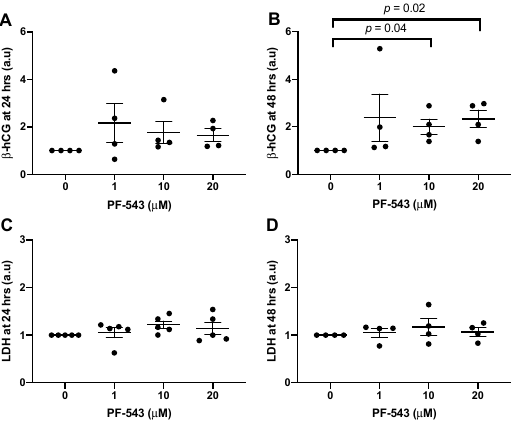
Figure 8. SphK1 inhibition with PF-543 increased β -hCG secretion after 48 h. Explants were pre-cultured for 4 days prior to treatment with a PF-543 dose response (0–20 μ M). Supernatants were centrifuged at 15,000 RPM for 15 min prior to quantification of β -hCG and LDH. ( A ) and ( B ) represent β -hCG released into the supernatant after 24 and 48 h, respectively as measured by ELISA. ( C ) and ( D ) represent LDH released into the supernatant after 24 and 48 h, respectively as measured with a colorimetric assay. Results were normalized against total protein mass and normalized values were graphed as a ratio of change from the untreated control explant cultures. ( n = 4–5, Mean ± SEM, Kruskal – Wallis test with the two-stage linear step-up procedure of Benjamini, Krieger, and Yekutieli post-hoc test).